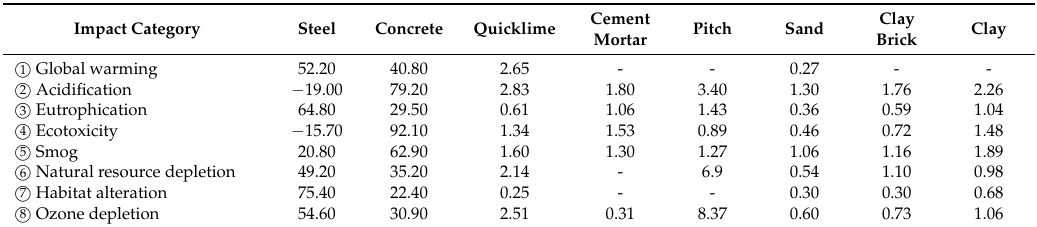
Table 4. The contribution of environmental emissions to various environmental impact categories in construction phase (%).